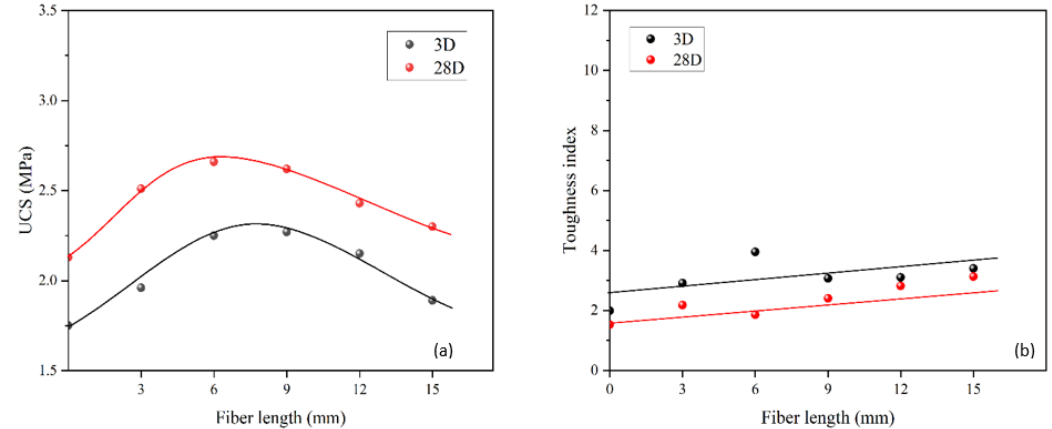
Figure 12. UCS for different fiber lengths ( a ) and toughness indices for different fiber lengths ( b ) at rubber content of 60% and fiber content 0.2%.